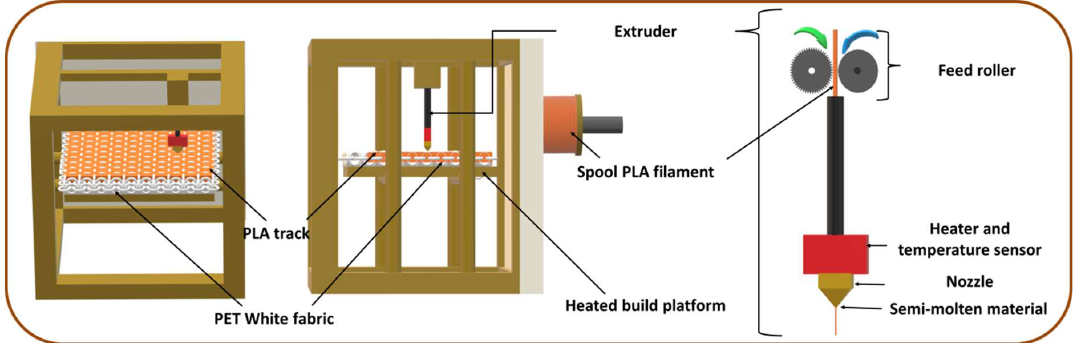
Figure 1. Fused deposition modeling process onto textiles.